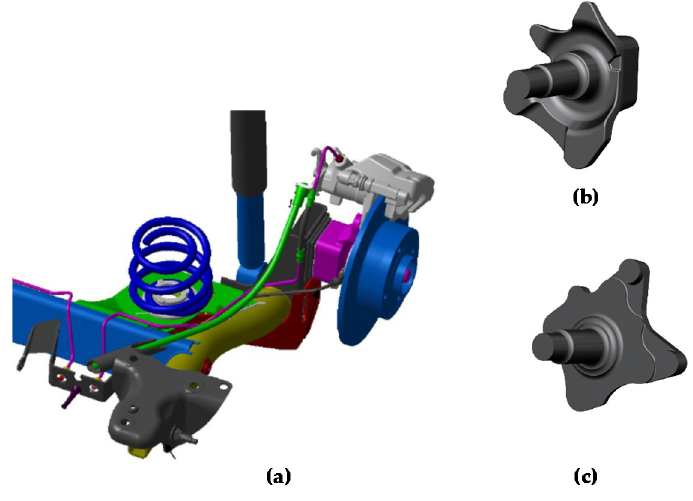
Figure 4. CAD drawing of ( a ) the rear suspension with the spindle in violet, ( b ) the R spindle (~3 kg), and ( c ) the H spindle (~2.3 and ( c ) the H spindle (~2.3 kg).